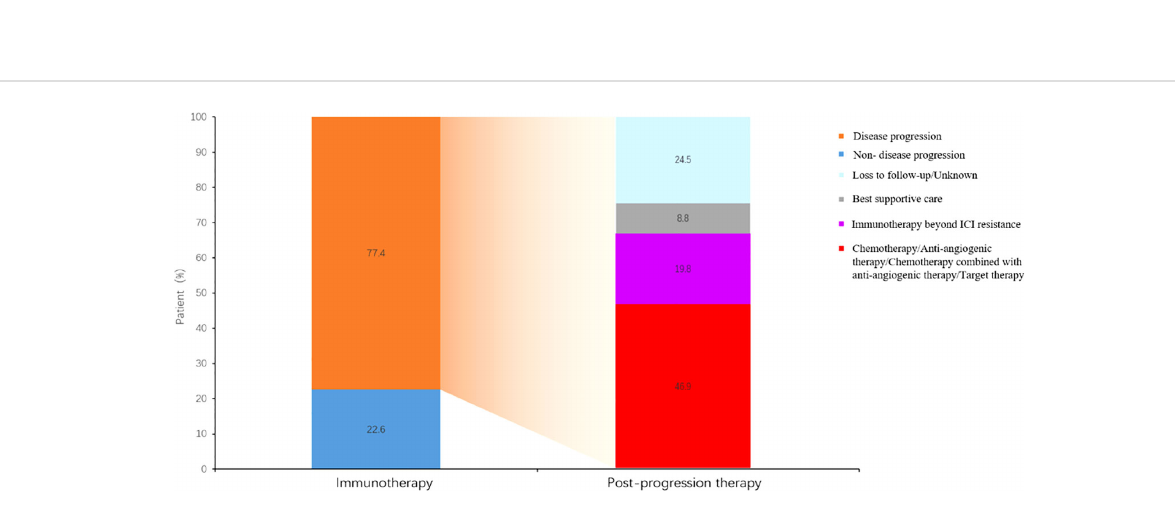
FIGURE 5 Therapeutic regimens beyond ICI resistance.